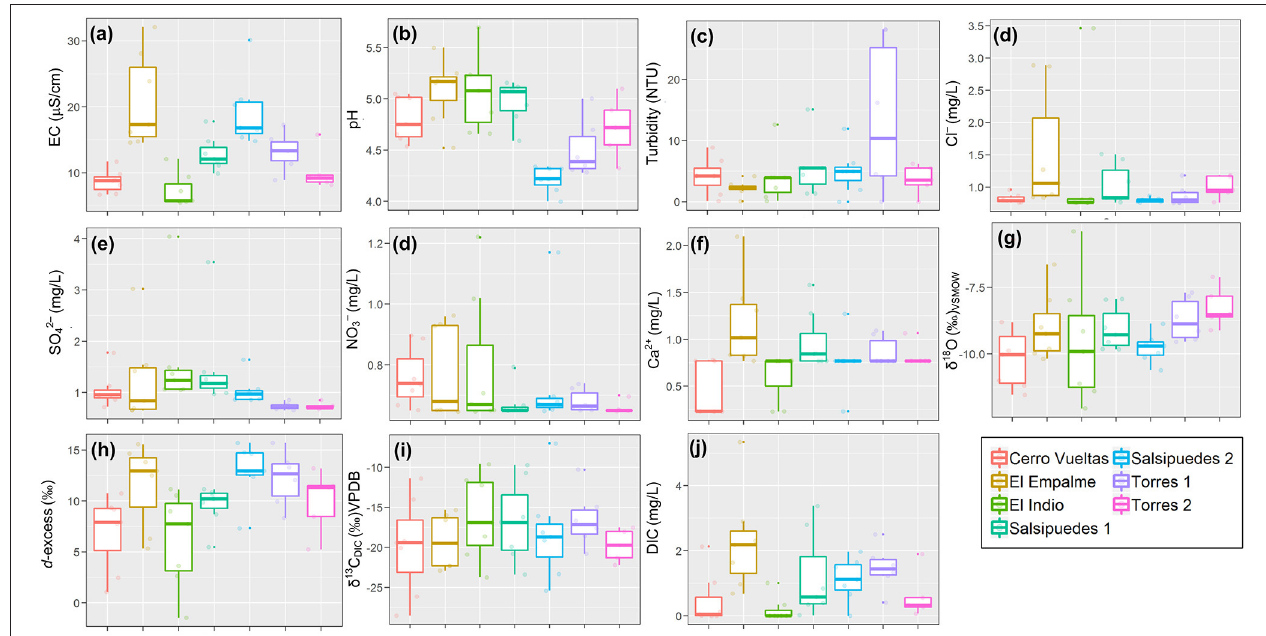
FIGURE 3 | Box plots (with individual data points) of physico-chemical (EC, pH, turbidity), water stable isotopes ( δ 18 O and d -excess), major ions (Cl − , SO 2 − 4 , NO − 3 , Ca 2 + ), dissolved inorganic carbon (DIC), and carbon stable isotopes ( δ 13 C DIC ). Sampling sites are color-coded and plots include 25th, 75th, median, and outliers. El Empalme and El Indio represent the lowest and highest sampling sites, respectively (see Figure 1 ).